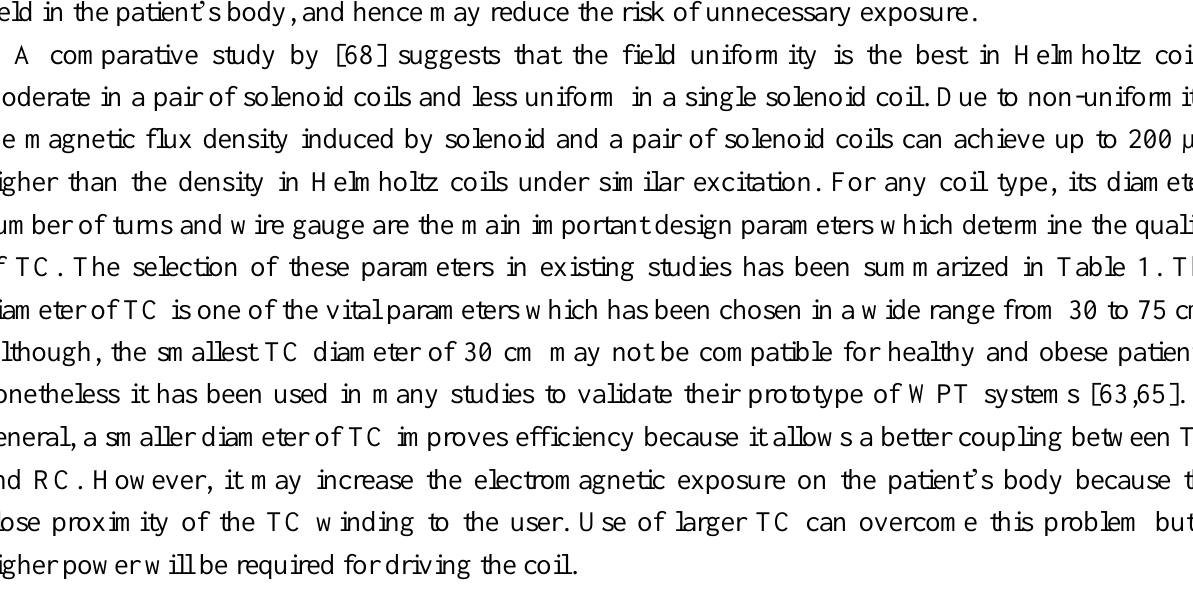
Table 1. Basic design parameters of transmitting coil used in existing